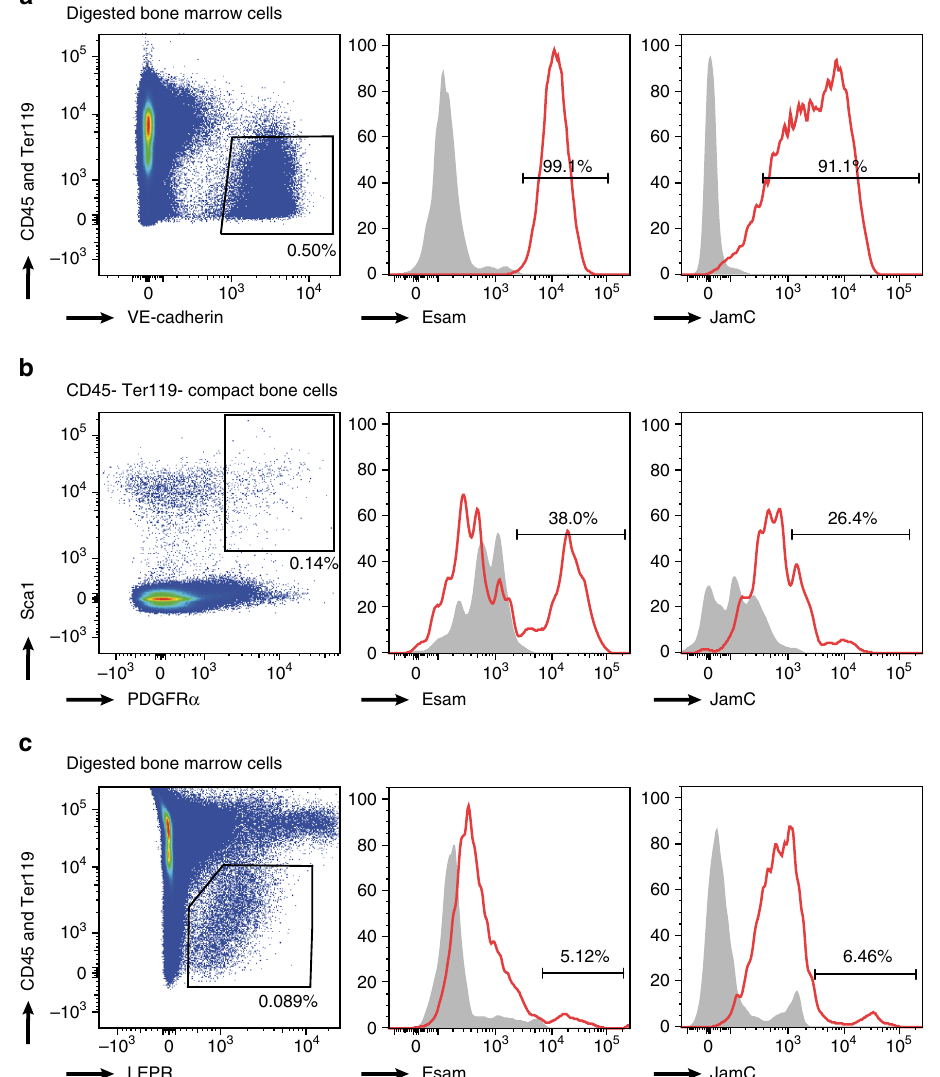
Fig. 4 Esam and JamC are expressed on endothelial, mesenchymal, and perivascular niche cells. Flow cytometry plots showing in red the percentage of Esam or JamC expression on a VE-Cad + CD45-Ter-119- digested bone marrow cells, or b PDGFR α + Sca-1 + CD45-Ter-119- digested compact bone cells, or c LEPR + CD45-Ter-119- digested bone marrow cells. Filled gray histograms show FMO ( fl uorescence minus one) controls for Esam and JamC. See also Supplementary Fig.